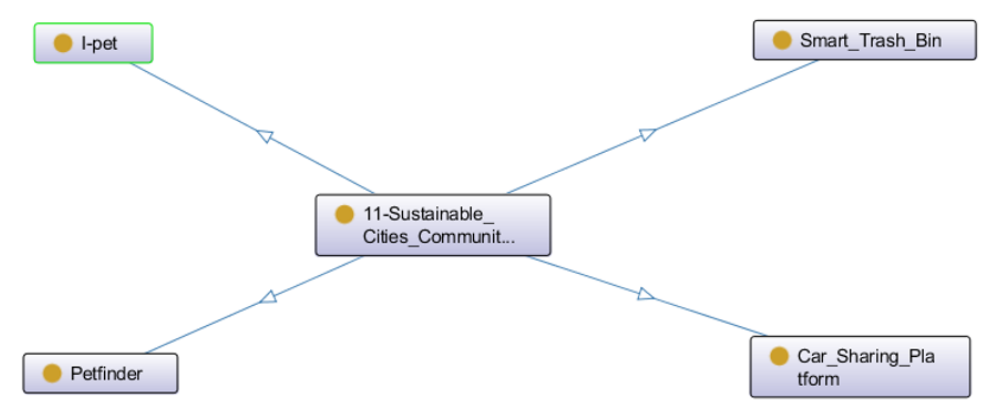
Figure 19. Projects related to the SDG